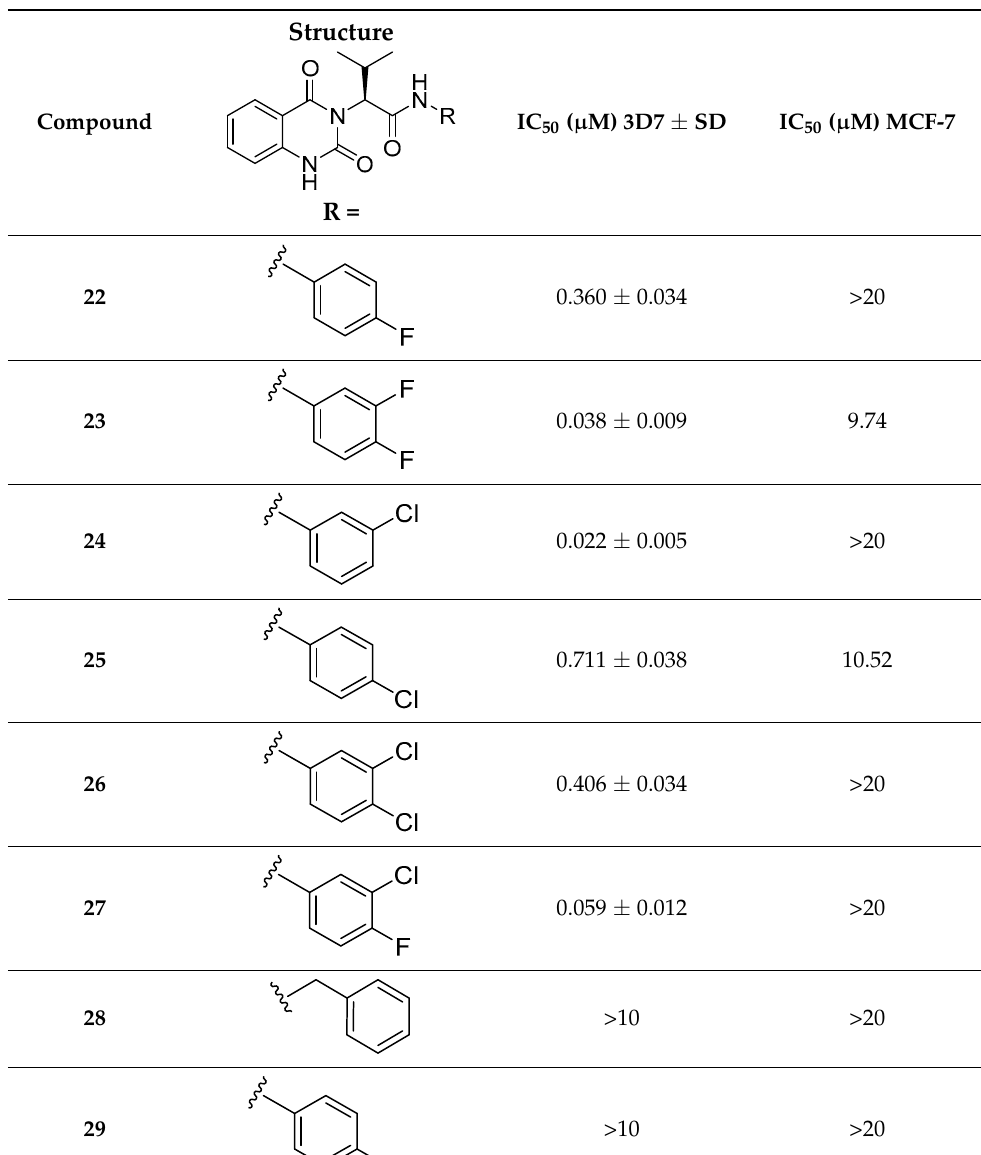
Table 3. In vitro antimalarial activities against P. falciparum 3D7 and cytotoxicity against MCF-7 cells of quinazolinedione derivatives with various amine side Table 3. Cont.